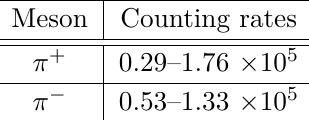
Table 1 . Estimated counting rates at JLab for π ± γ